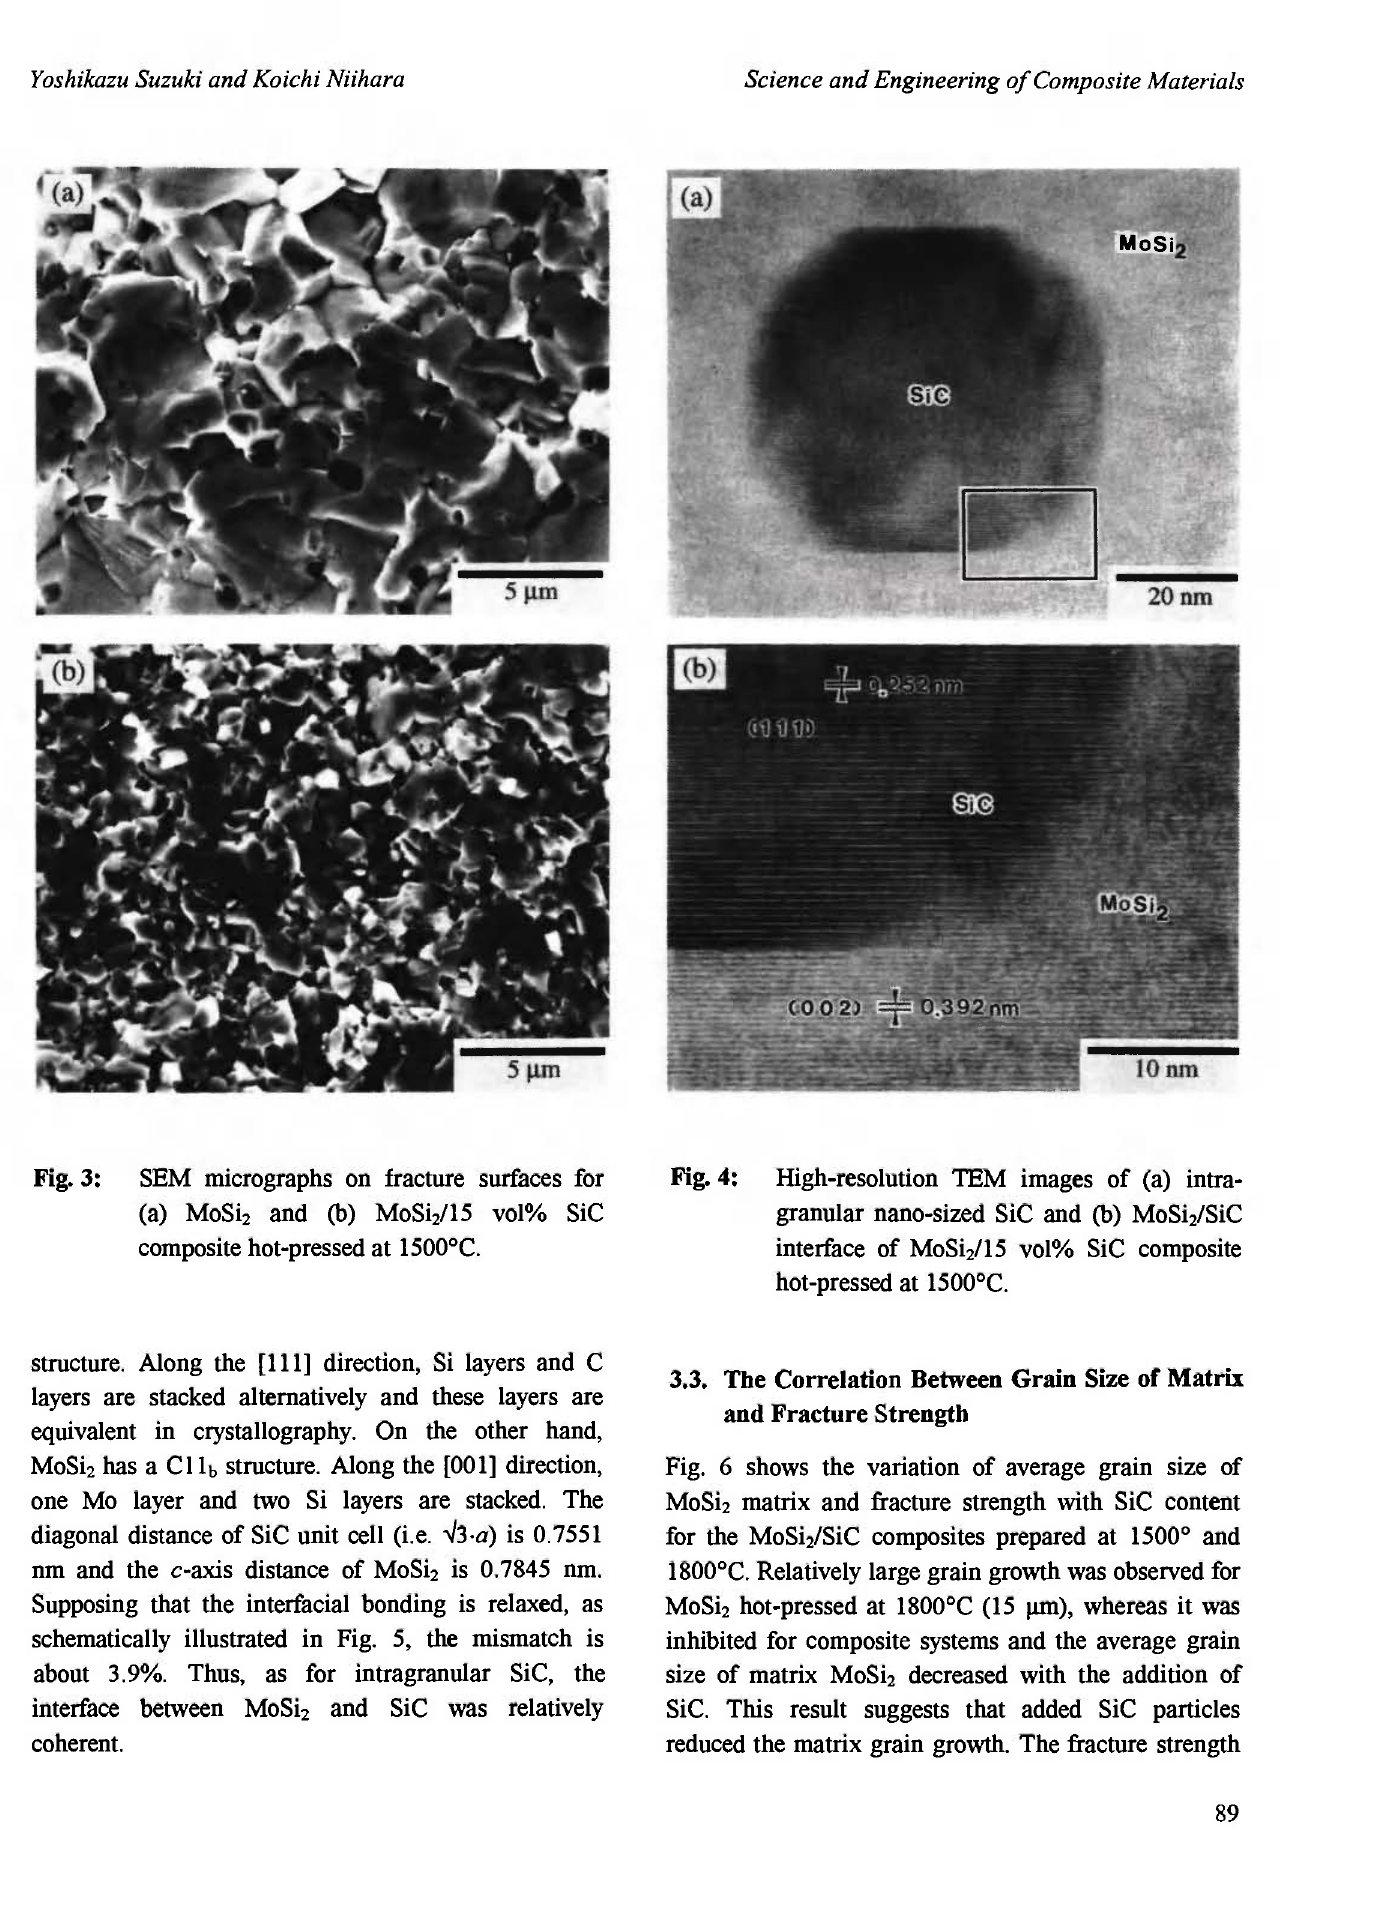
Fig. 4: High-resolution TEM images of (a) intra- granular nano-sized SiC and (b) MoSi interface of MoSi /15 vol% SiC composite 2 hot-pressed at